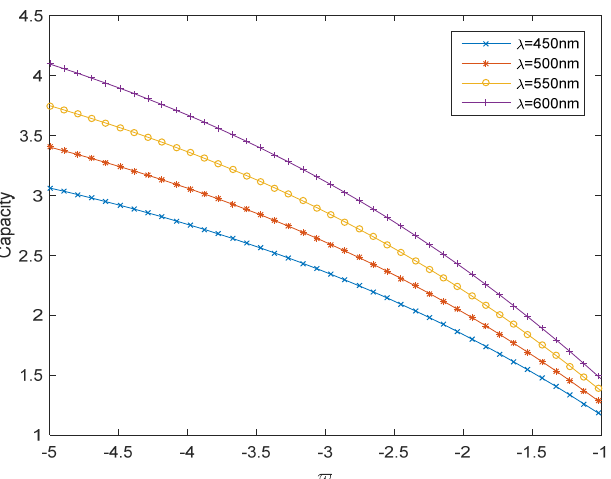
Figure 8. Channel capacity of the link with the random double-position power Gaussian vortex carrier communication system versus temperature–salinity contribution ratios and different values of wavelength λ .